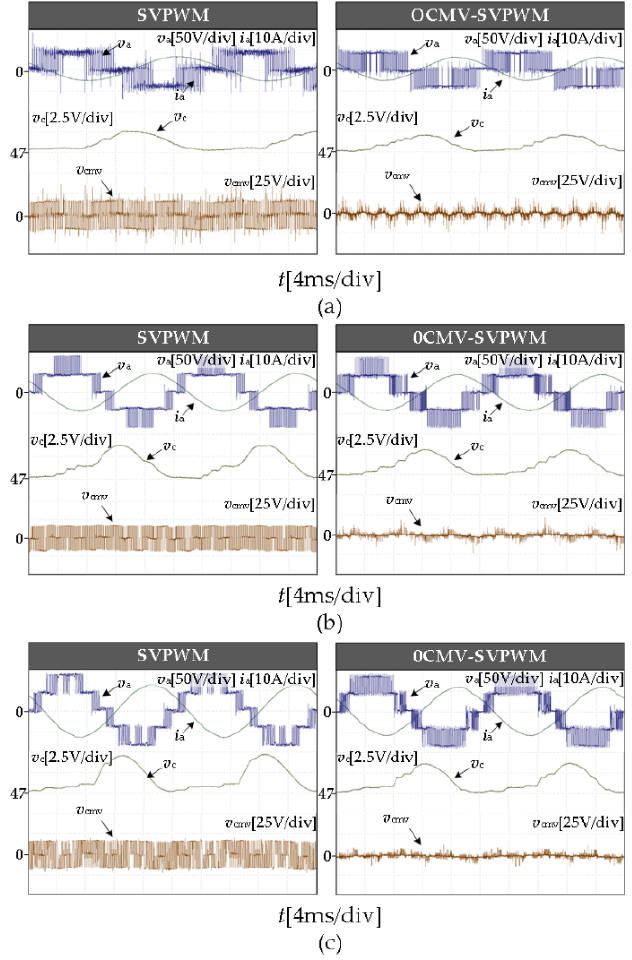
Figure 11. Experimental results of different m: ( a ) m = 0.4 ( b ) m = 0.6 ( c ) m = 0.8.